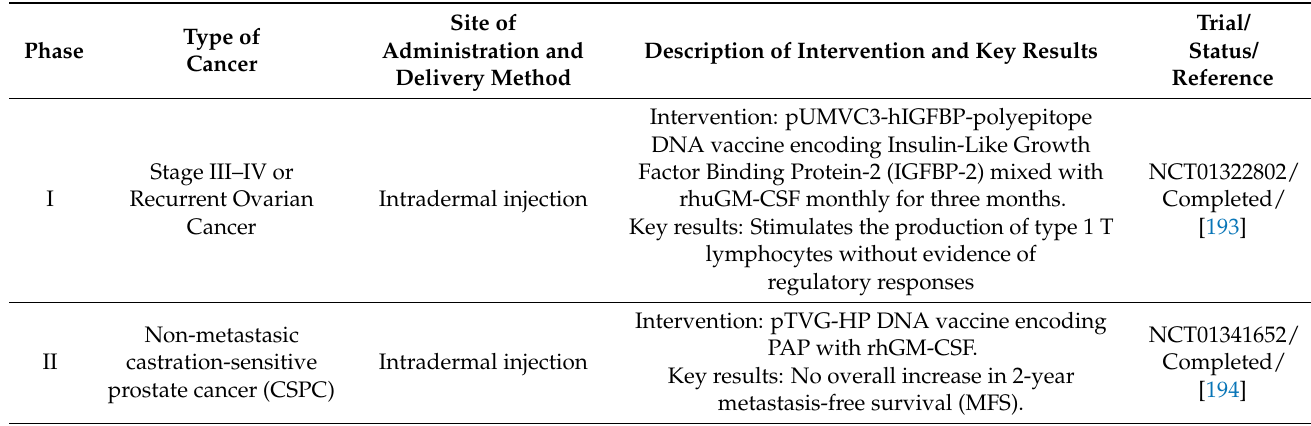
Table 2. Clinical trials using DNA vaccines for cancer